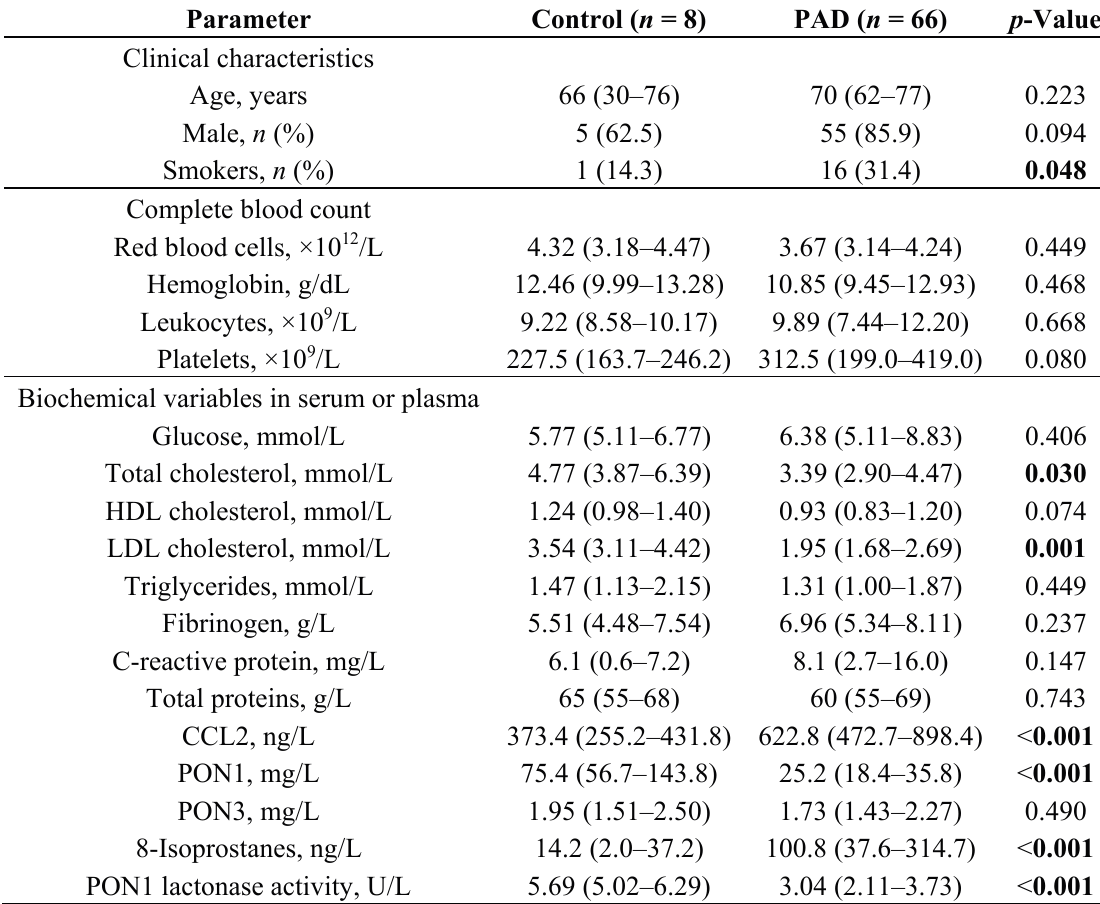
Table 1. Selected descriptive characteristics and laboratory variables in